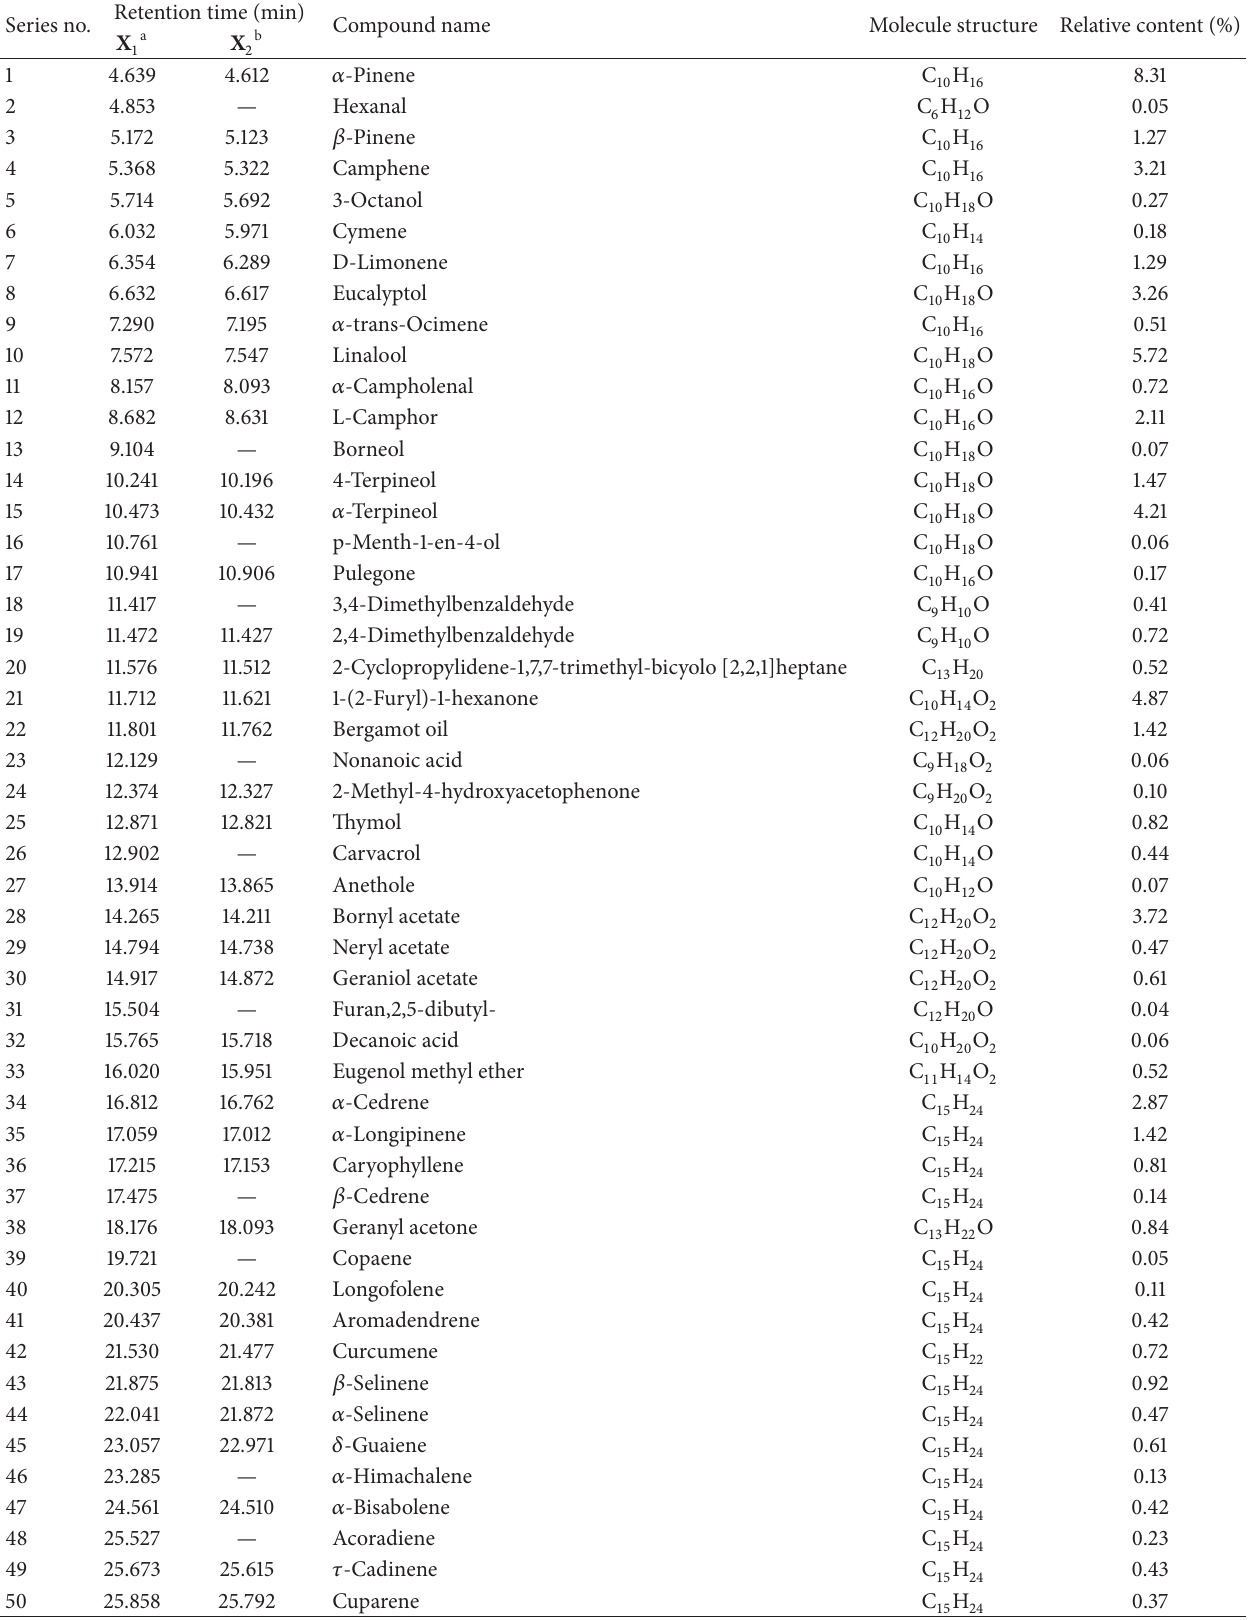
Table 1: Identification and quantification of the volatile chemical constituents in main root and leaf of Agrimonia eupatoria . Retention time Series no.